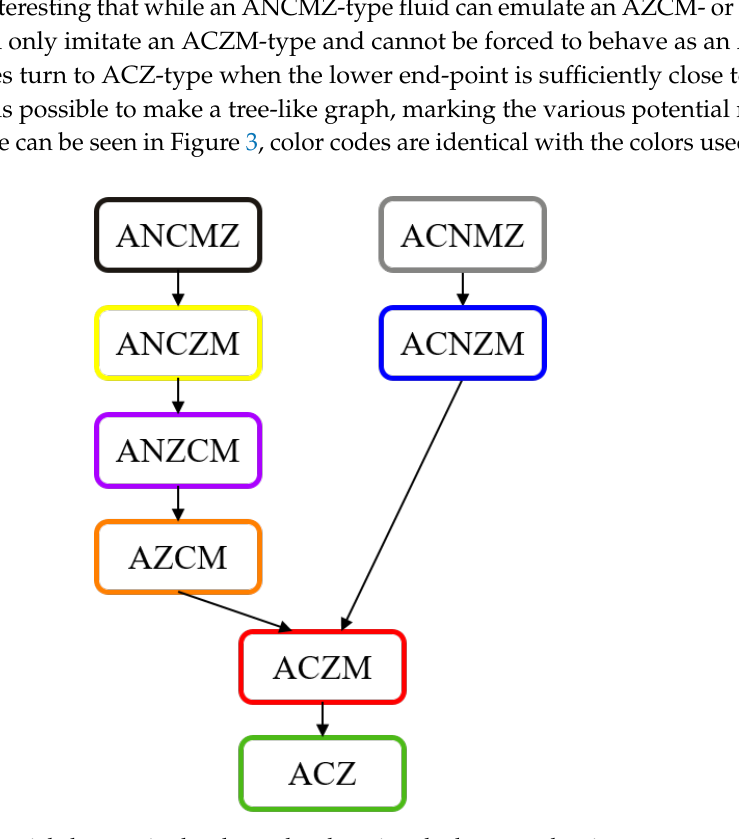
Figure 3. The potential changes in the classes by changing the lower end-point temperature. Color codes are identical with the colors of Figures 2 and 4.